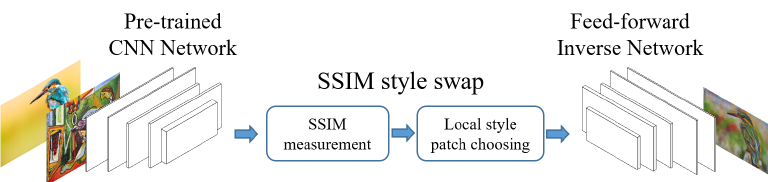
Figure 1. The structure of our